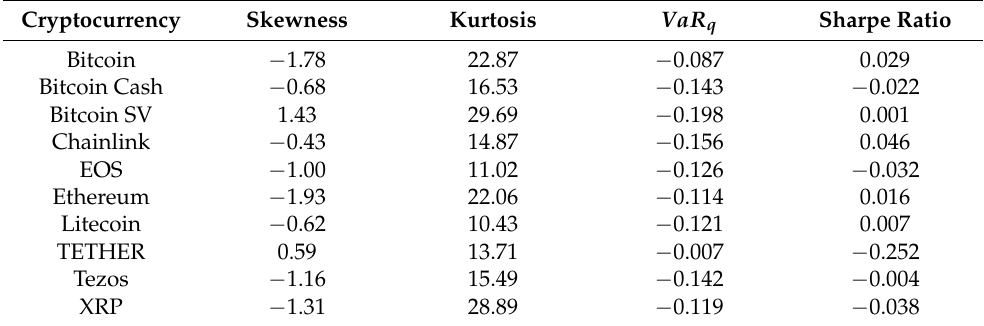
Table 5. Higher moments and value at risk ( q =